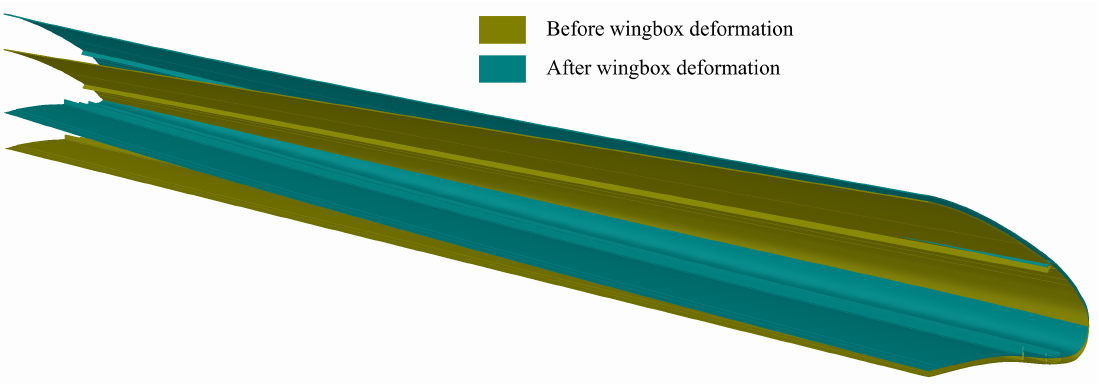
Figure 22. Virtual test: undeformed model ( a ); actuated leading edge model ( b ); deformed wing-box and actuated droop nose model ( c ).